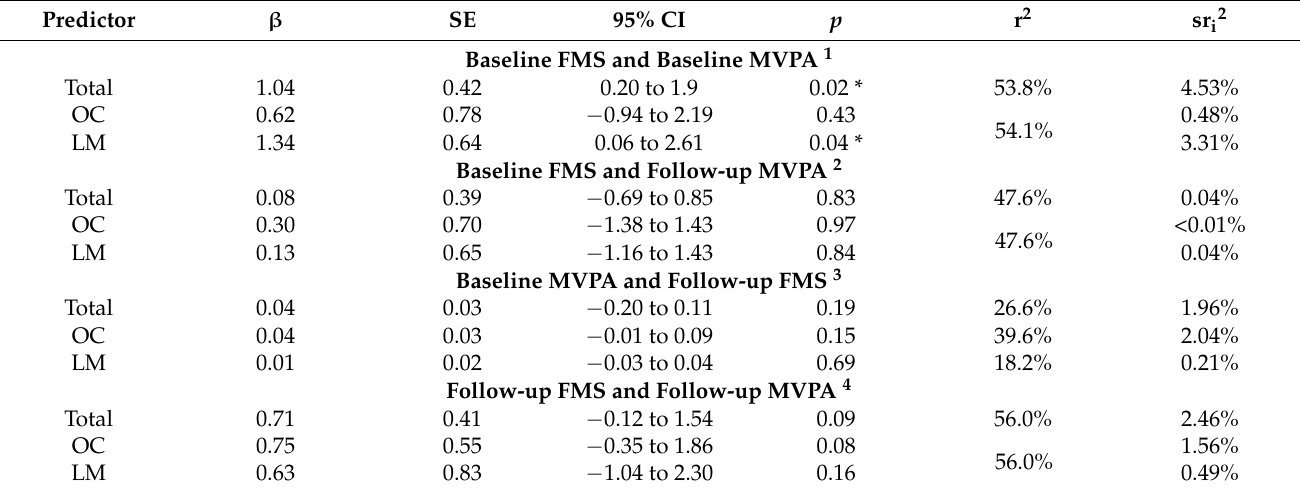
Table 4. Results from linear regression examining associations between FMS scores and